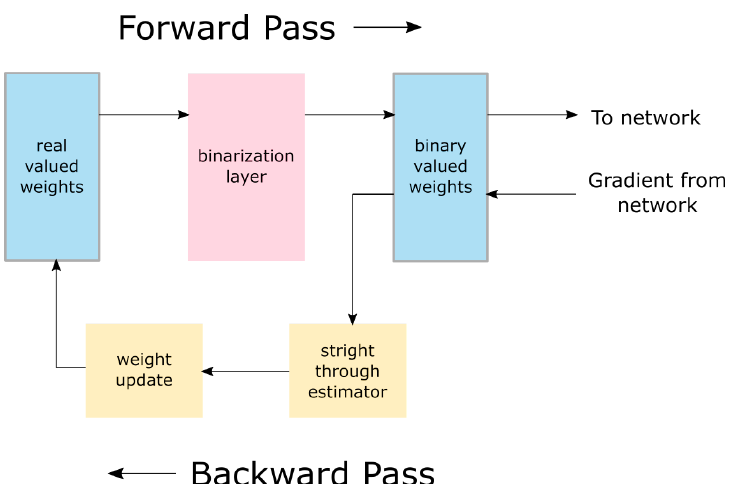
Figure 1. Visualization of a binarization layer in a BNN. Real valued weights are stored behind a binarization layer. During the forward pass, these real valued weights are binarized and passed forward through the network. During the backward pass, the gradients bypass the binarization layer, and instead are passed through a straight through estimator and used to update the real valued